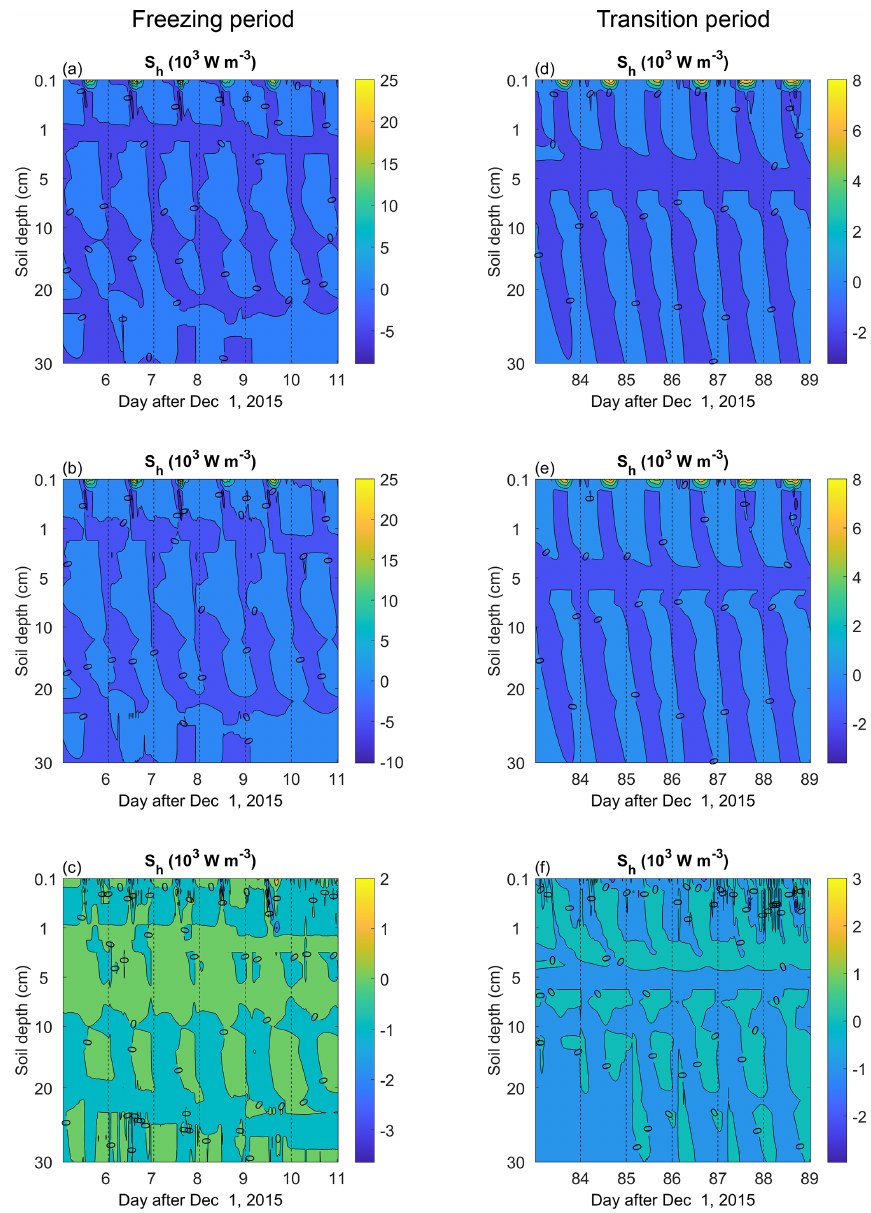
Figure 8. The spatial and temporal distributions of model-estimated soil latent heat flux density using the (a, d) advanced coupled model (ACM), (b, e) advanced coupled model with airflow (ACM–AIR), and (c, f) the difference between ACM and ACM–AIR simulations ( S h , ACM-AIR − S h , ACM ) during the typical 6d freezing and freezing–thawing transition periods. The left (a–c) and right (d–f) columns are for the freezing and freezing–thawing transition periods, respectively. Note that figures for the basic coupled model (BCM) are absent as the model cannot simulate the subsurface soil latent heat flux